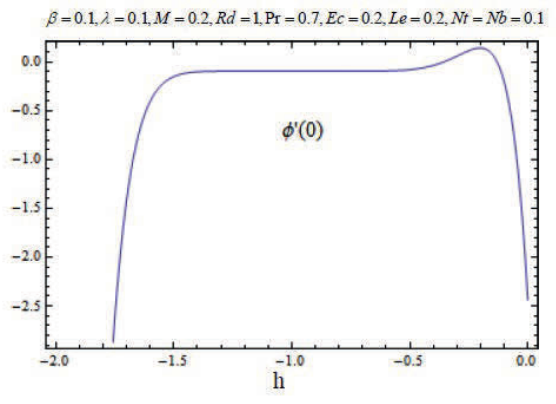
Fig. 4: h ϕ curve for functions ϕ for 20 th -order of HAM approxima-